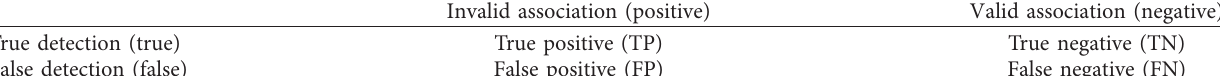
Table 2: Confusion matrix of the valid association detection.